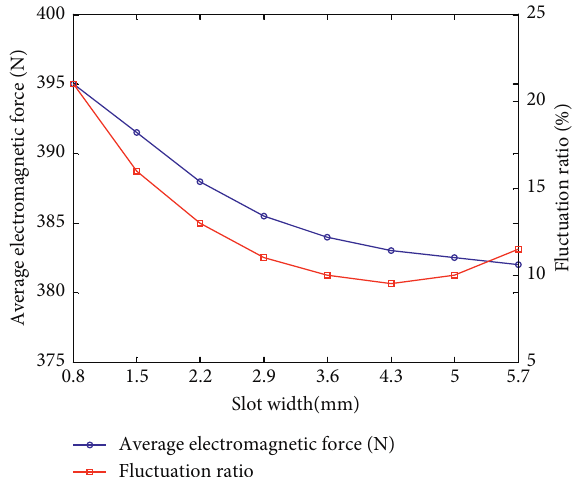
Figure 8: Changes of average electromagnetic force and fluctuation ratio with slot width.